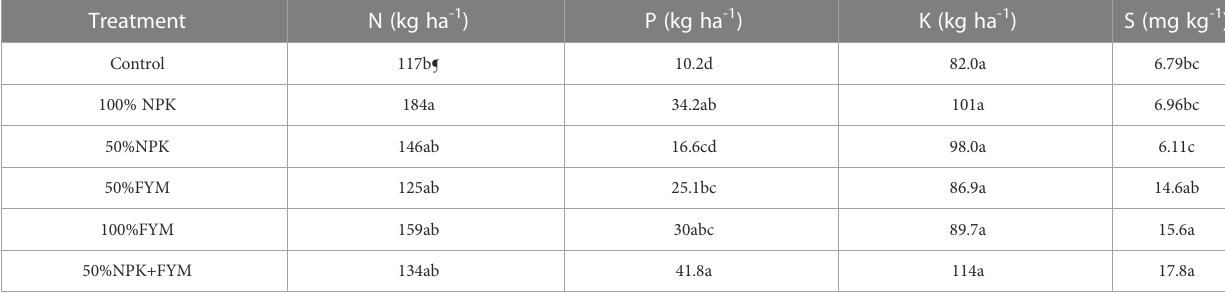
TABLE 2 Effect of long-term fertilization and manuring on soil macro- nutrients. Treatment